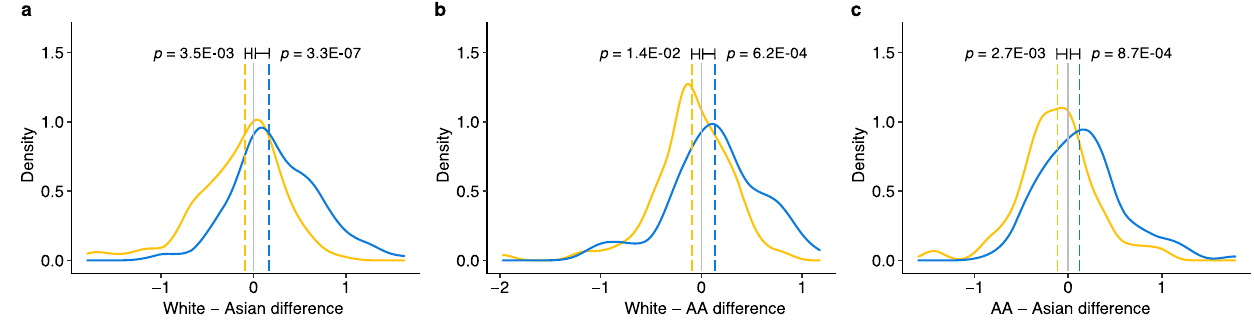
Fig. 3 | Validation of MiXcan epithelial cell GReX predictions using mammary epithelial cell snRNAseq data. Measured mammary epithelial cell snRNAseq levels for three GTEx women of White, Asian, and African-American (AA) ancestry were compared for six sets of 100 genes predicted to have the largest GReX dif- ferences in each pair of women. Distributions of the observed differences in the